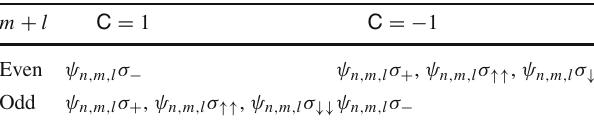
Table 2 Basis states ψ nml σ s ¯ s categorized by the charge conjugation C according to Eq. (18) m +